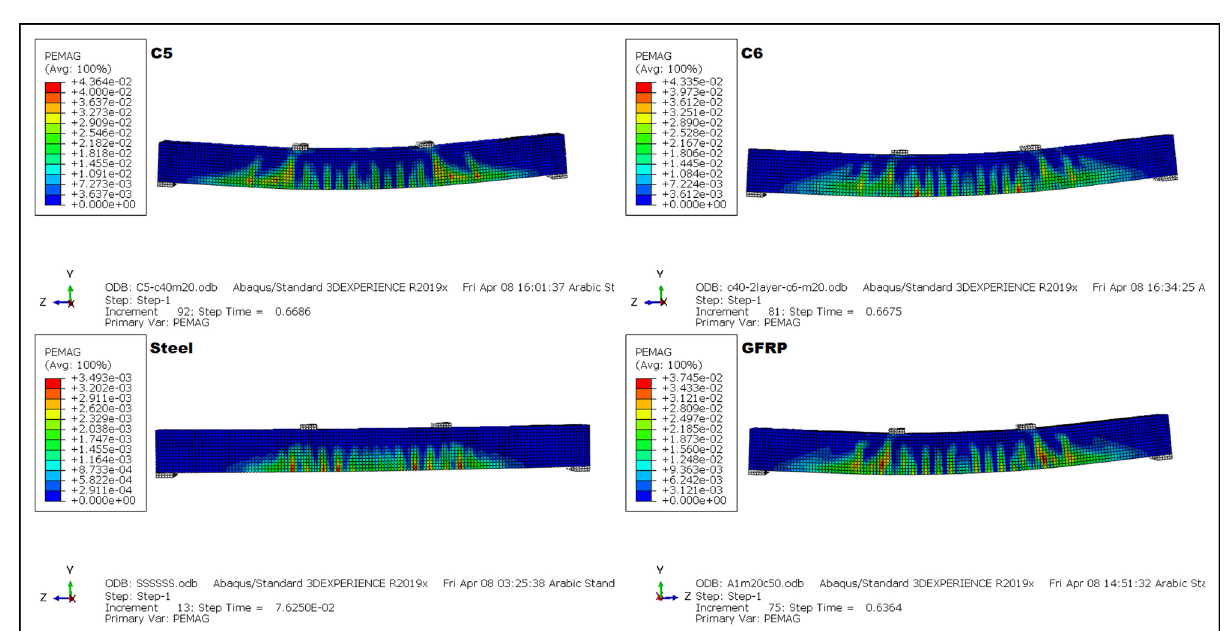
Figure 18: Cracks ’